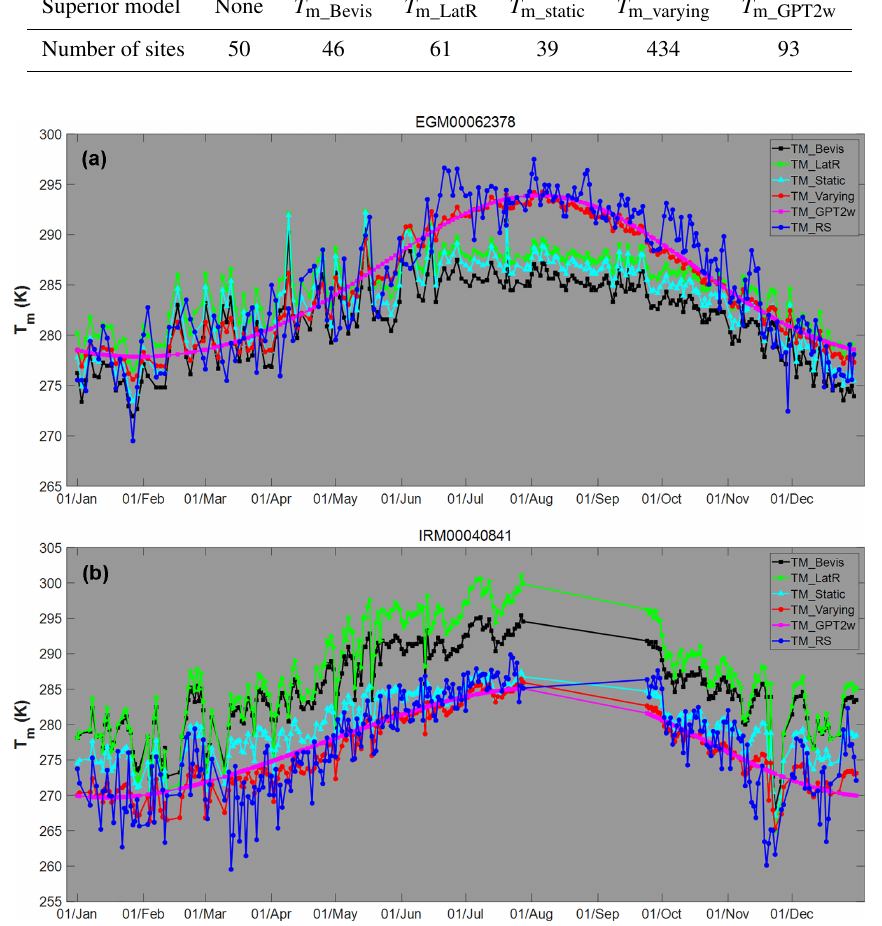
Figure 8. T m series of T m_Bevis , T m_LatR , T m_static , T m_varying , T m_GPT2w and T m_RS at the IGRA station (a) no. 62378 and (b) no. 40841. Temperature unit is